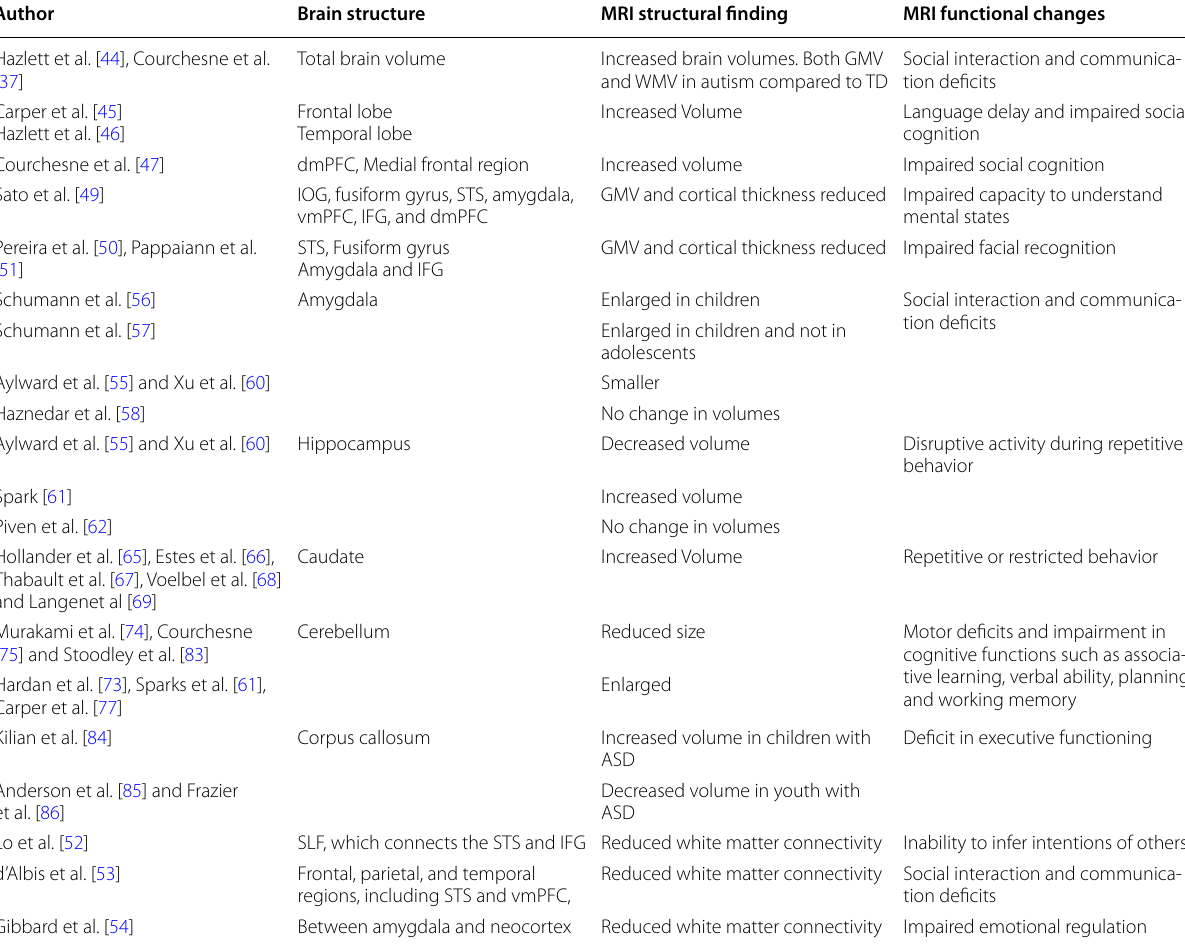
SLF Superior longitudinal fasciculus, STS Superior temporal sulcus, IOG inferior orbital gyrus, vm PFC Ventromedial prefrontal cortex, dmPFC dorsomedial prefrontal cortex, ILF inferior frontal gyrus, GMV grey matter volume, WMV white matter volume, TBV total brain